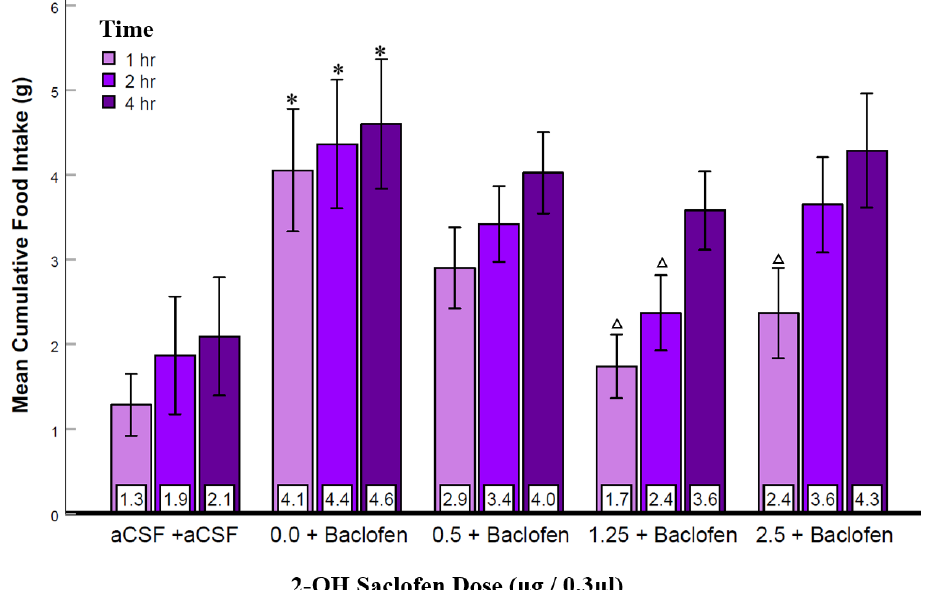
Figure 5. 2-OH saclofen injected into the LS suppressed baclofen-elicited food intake. Error bars: ±SEM; n = 13; mean values are shown at the bottom of the bar. * indicates significant differences from the aCSF group at matched times at p < 0.05. ∆ indicates significant differences compared to the baclofen and the 0.5 µ g 2-OH saclofen groups at matched times at p <